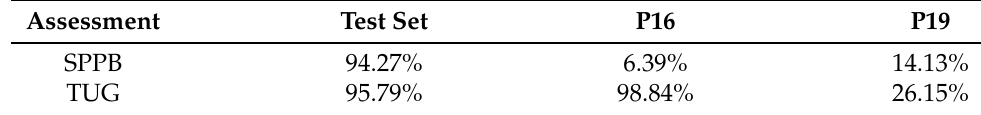
% at epoch 67. Figure 7. The ROC curve of the TUG model. Figure 8. The ROC curve of the SPPB model.